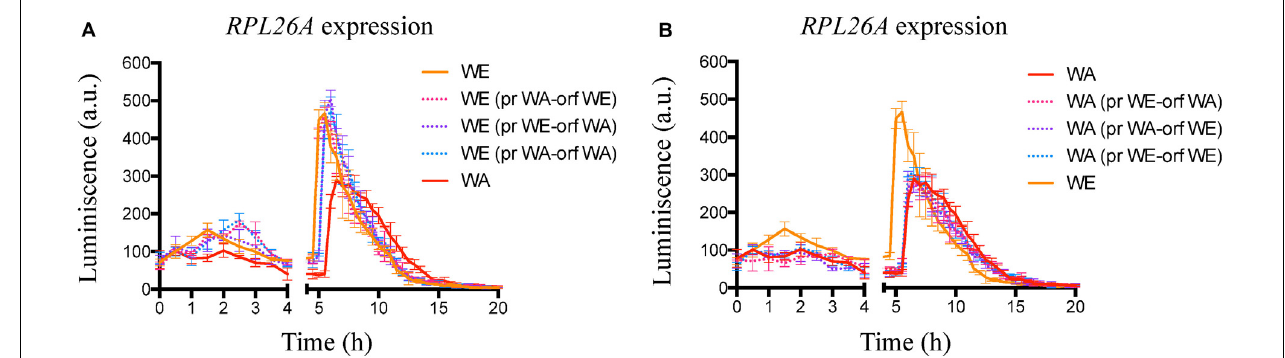
FIGURE 5 | Indirect TORC1 activity in strains with GTR1 swapped regions. (A) Indirect monitoring of TORC1 activity in the WE strains with swapped regions of GTR1 coming from the WA strain, using micro culture conditions until 20 h. (B) Indirect monitoring of TORC1 activity in the WA strains with swapped regions of GTR1 coming from the WE strain, using micro culture conditions until 20 h. Plotted values correspond to the average of three biological replicates, with their standard error represented by bars (mean ± SE). WE, Wine/European; WA, West African; pr, Promoter; orf: Open Reading Frame (ORF).